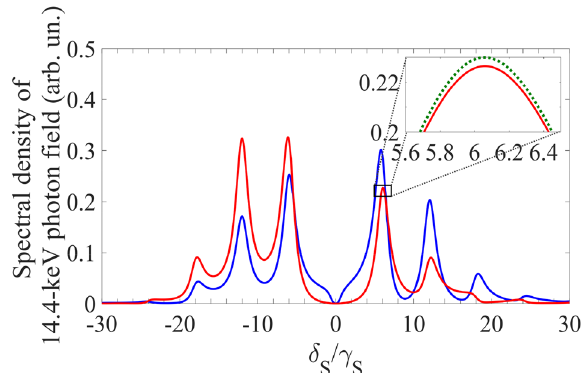
Figure 3. (Color online) Spectrum of the single-photon wave packet with Lorentz spectral shape, transmitted through the vibrating absorber under the AIT condition (Eq. 7) in the absorber reference frame. Blue and red curves correspond to those in Fig. 2. They are plotted as the normalized function 0 , T 5 , γ 3 , and T e E S (δ S ) in the form of (Eq. 18) at the same as in Fig. 2 parameter values M = S /γ 21 = ˜ = 0 (the blue curve) and ϑ 6 ) for ϑ ω 21 , p p 1 , �/γ S ( ω SC = = = = maximum difference between the transmitted field and the incident field (the green dotted curve, the same as the red solid curve in Fig. 2), occurring near the peak of the first